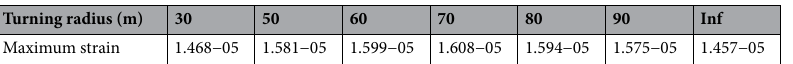
Table 1. For the vehicle going into a turn, the maximal strain was computed for various vales of the radius. The parameters are the same as in Fig. 6. The maximume strain occurs at a radius of appears to decrease with increasing radius, until it eventually converges to the value for a straight vehicular